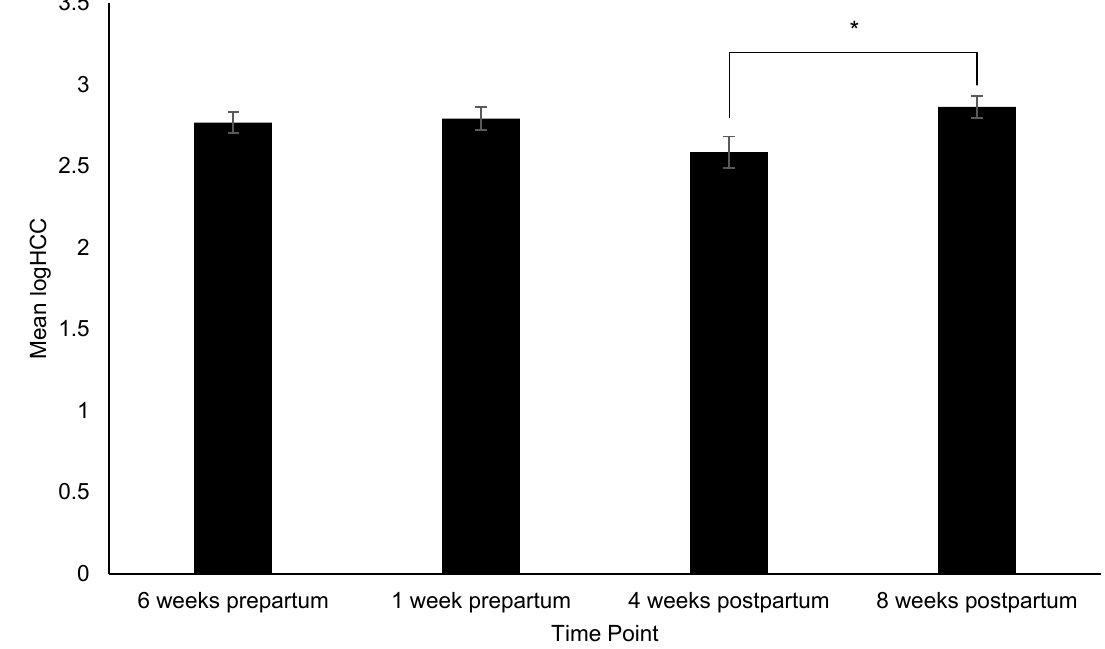
Figure 3. Change in treat consumption throughout the Field Instantaneous Dog Observation Tool + (FIDO+) across time points. Sample sizes for each time point were n = 59, n = 38, n = 57, and n = 55, respectively. Error bars represent SE. * indicates p ≤ 0.05, ** indicates p < 0.01.